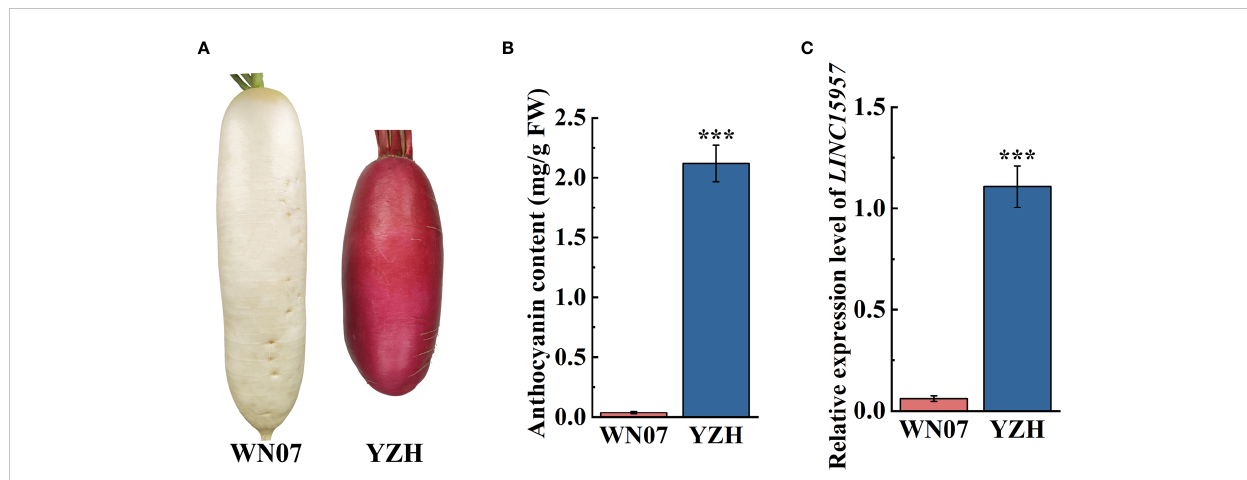
FIGURE 1 Anthocyanin content and related gene expression in radish with different colors. (A) Two radish cultivars “ WN07 ” and “ YZH ” with different colored radish. (B) Content of anthocyanin in root skin of “ WN07 ” and “ YZH ” radish. (C) The relative expression of LINC15957 in “ WN07 ” and “ YZH ” radish root skin. Error bars represent the mean ± SE of three biological replicates. ***p < 0.001, Student ’ s